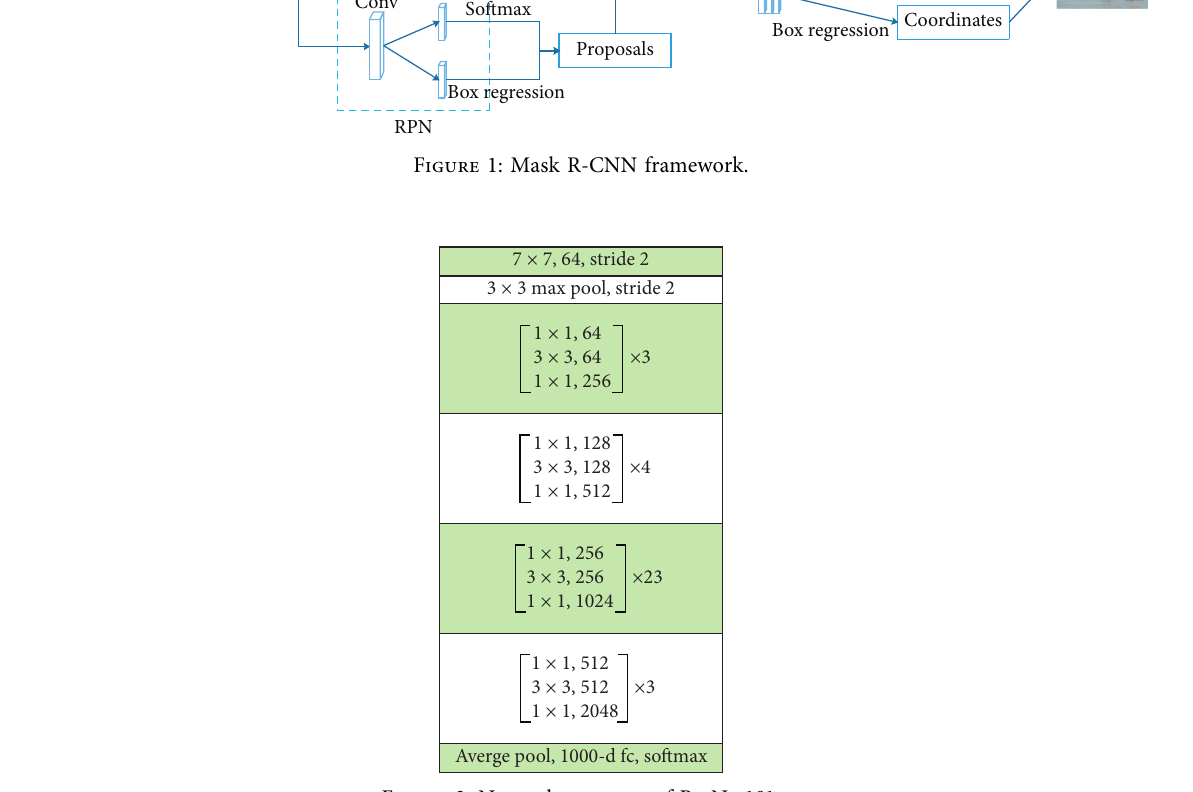
Figure 2: Network structure of ResNet101.